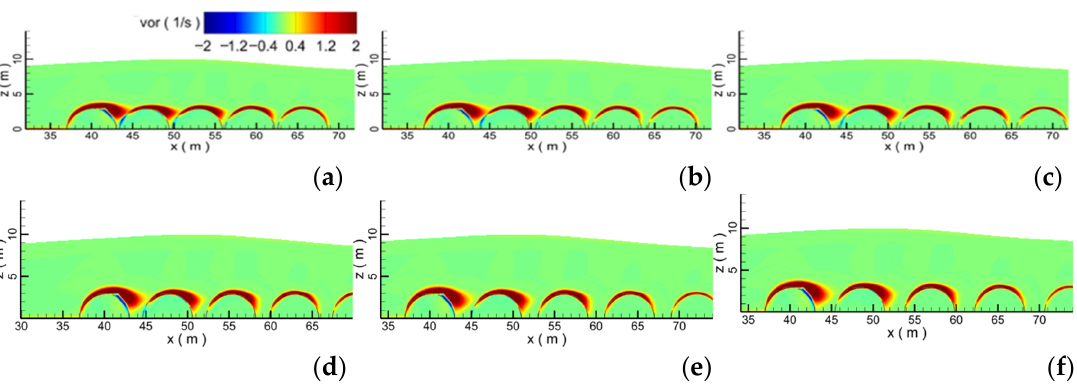
Figure 16. The velocity contour of the wave peak on the breakwaters under different distances; ( a ) s = 0.4 m; ( b ) s = 0.8 m; ( c ) s = 1.2 m; ( d ) s = 1.6 m; ( e ) s = 2.0 m; ( f ) s = 2.4 m.